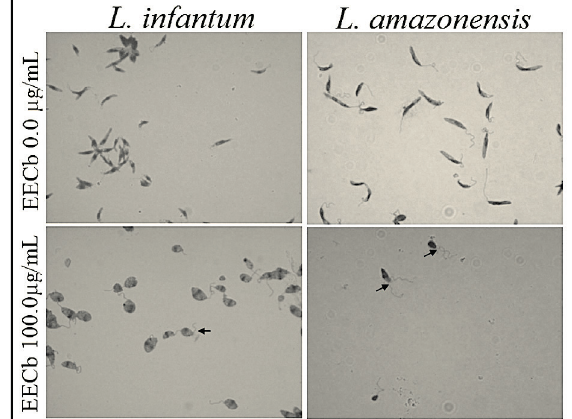
Figure 3. Effect of EECb on Leishmania promastigotes morphology as observed by microscopy. Untreated L. amazonensis and L. infantum promastigotes showing the typical elongated shape. L. amazonensis and L. infantum promastigotes treated with 100 µg/ mL of EECb showed body rounding, cellular volume reduction, and fl agellum duplication (arrowed). Magnifi cation: